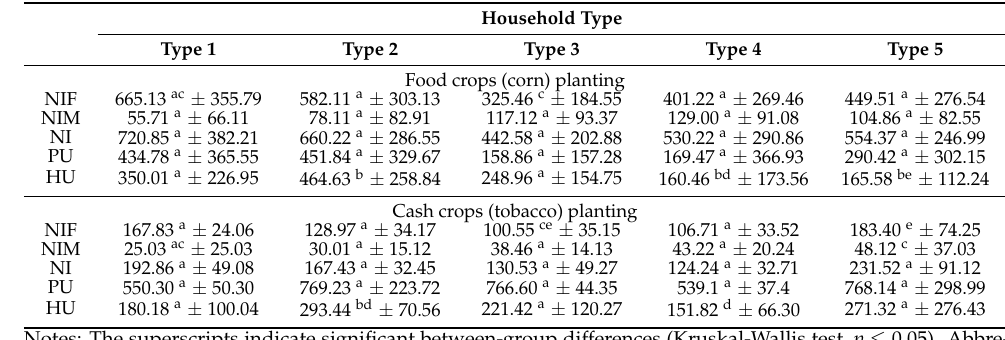
Table 7. Differences between household types regarding their cropland chemical disturbance behav- iors (mean ±